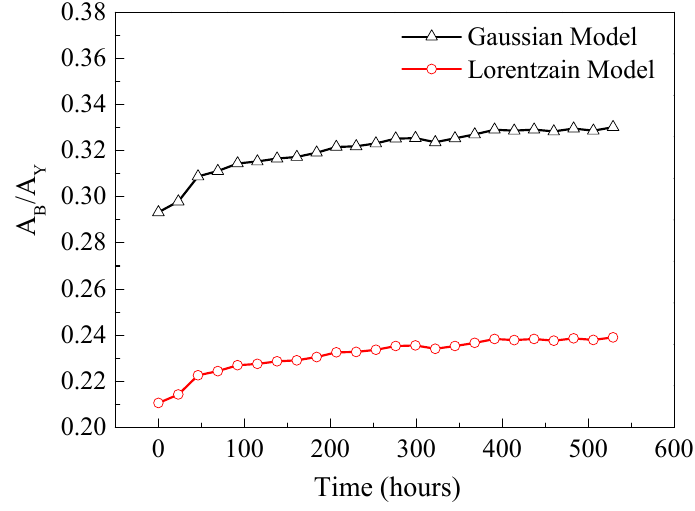
Figure 7. Ratio of extracted areas under the SPD curve.